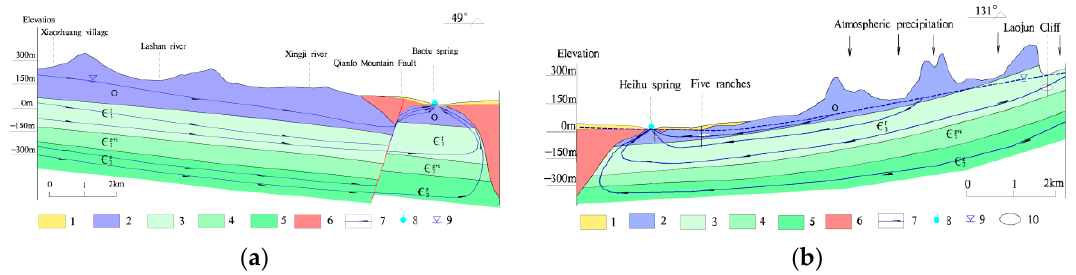
Figure 13. Schematic diagram of geological section. ( a ) І - І '; ( b ) Π - Π ' 1: Quaternary clay; 2: Ordovician carbonate; 3: Cambrian Fengshan Formation limestone; 4: Cambrian Gushan Formation and Changshan Formation limestone; 5: Cambrian Zhangxia Formation limestone; 6: magmatic rock; 7: groundwater flow line; 8: spring group; 9: water level; 10: karst cave.